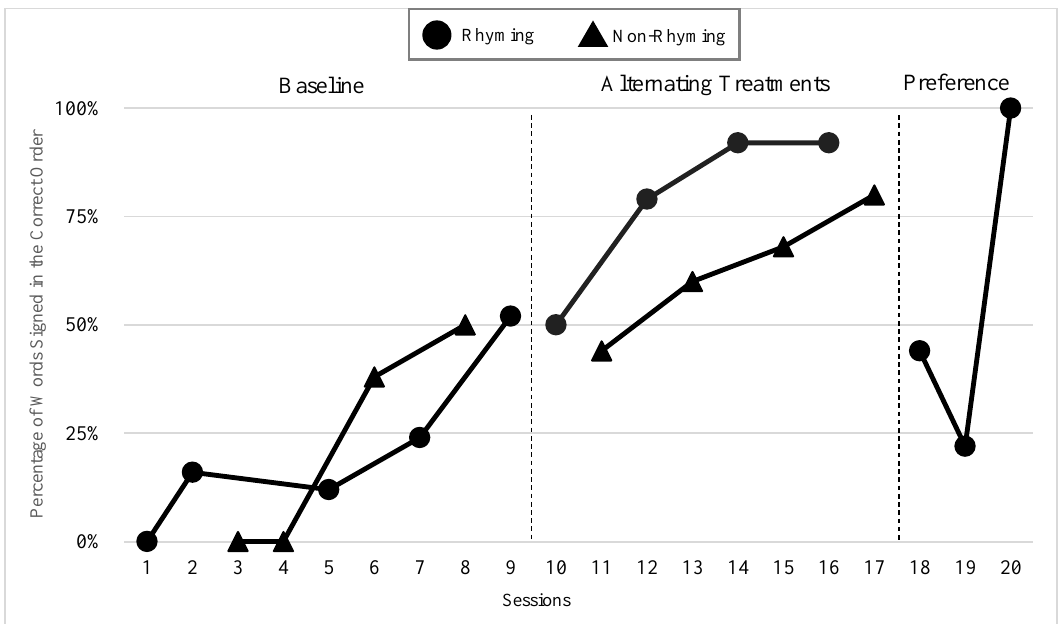
Figure 10. Yair’s Percentage of Words Signed in the Correct Order in Recitation. Children 2020 , 7 , x FOR PEER REVIEW